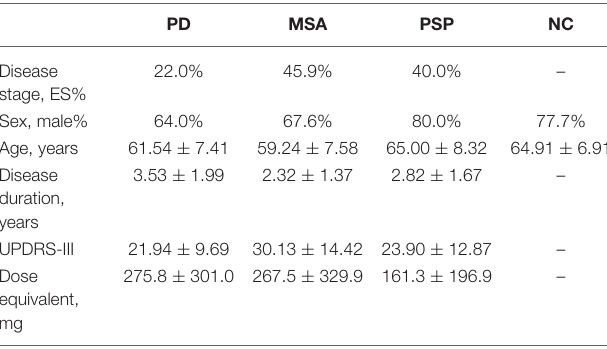
TABLE 1 | General characteristics of the study patients ( n = 107) and normal controls (NC) ( n =